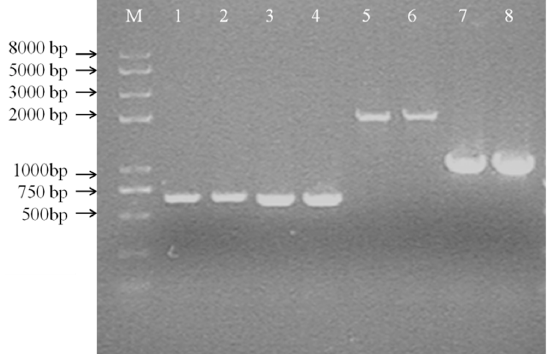
Figure 9. Colony PCR of the first crossover strain (A) (M: DNA Marker DL 8000; 1, 2: PCR product by Cm-F and Cm-R; 3, 4: PCR product by Ery-F and Ery-R; 5, 6: PCR product by dsr -up-F and Cm-R; 7, 8: PCR product by dsr -down-F and dsr